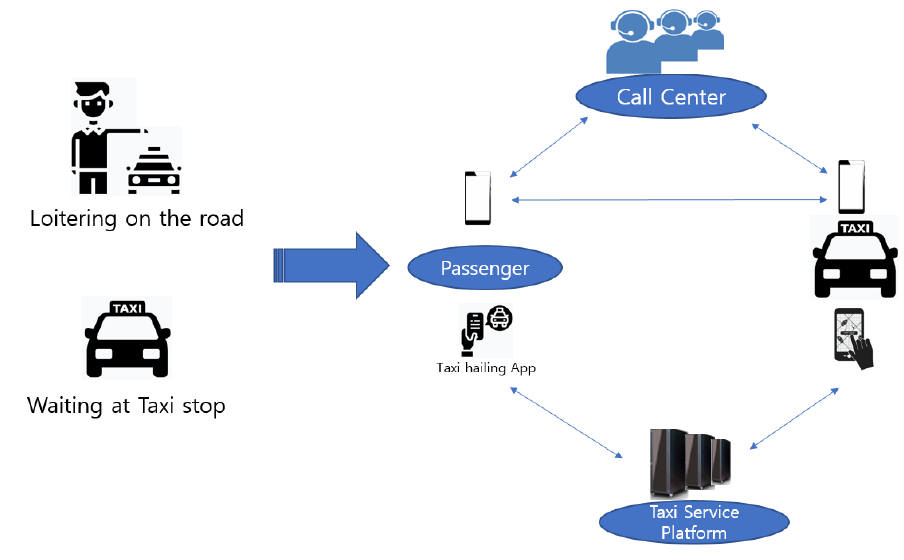
Figure 1. Movement within the taxi service